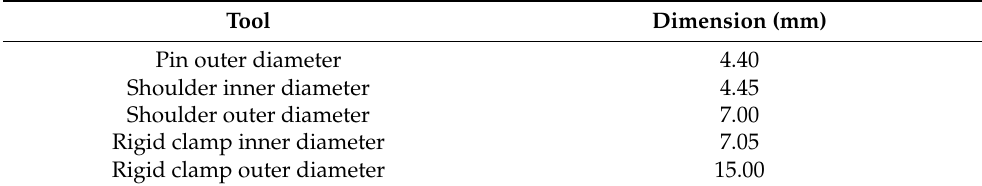
Table 1. Tool dimensions used for numerical model and validation.